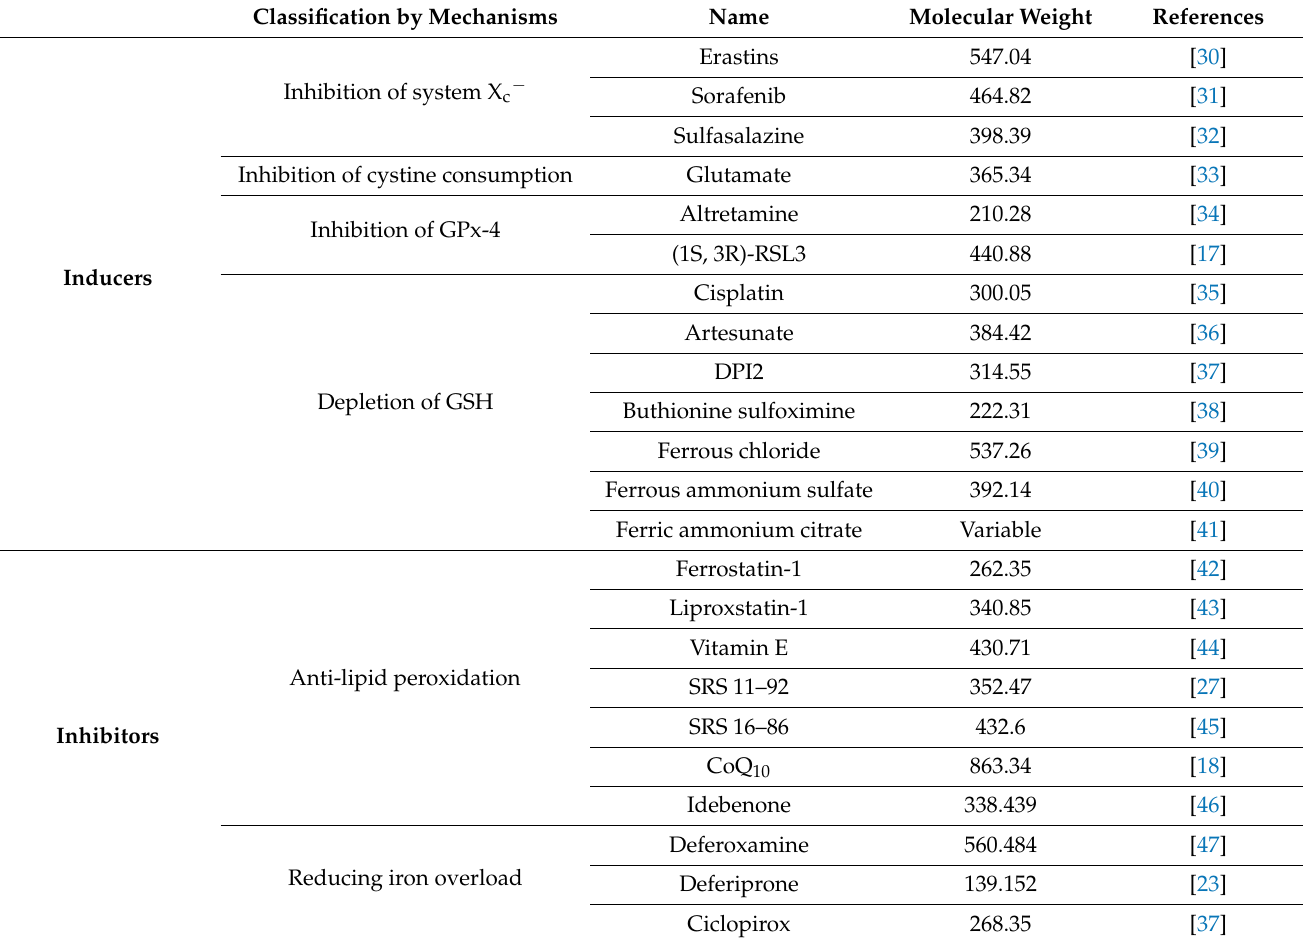
Table 1. A summary of molecules for ferroptosis